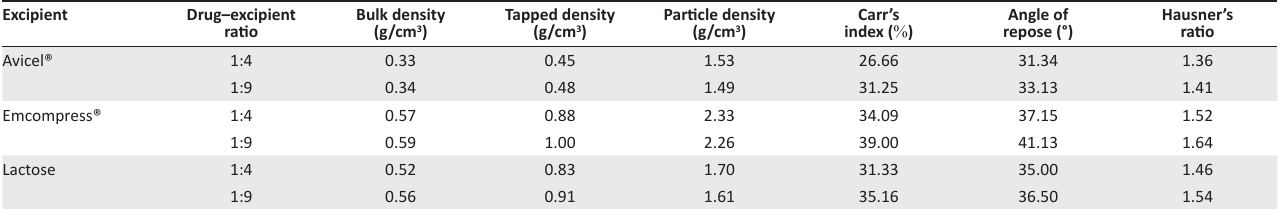
TABLE 2: Flow properties of the powder mixtures of Ficus exasperata extract and diluents. Excipient